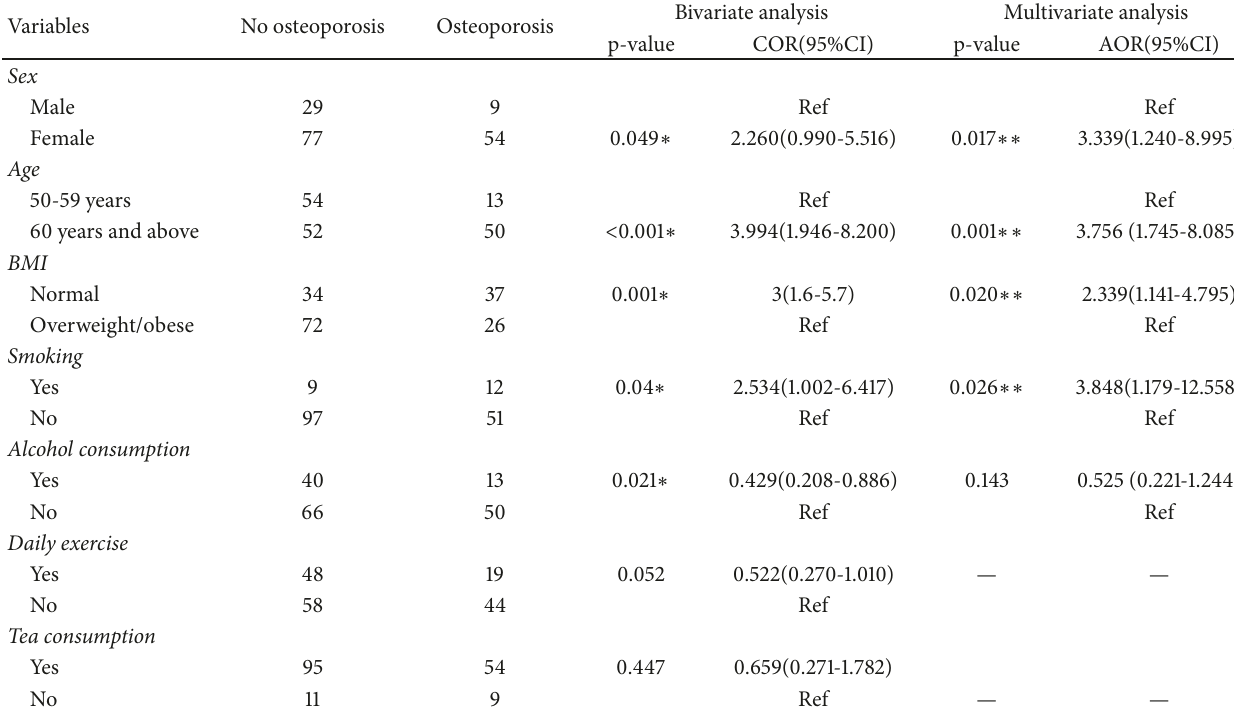
Table 4: Association of different variables with BMD.